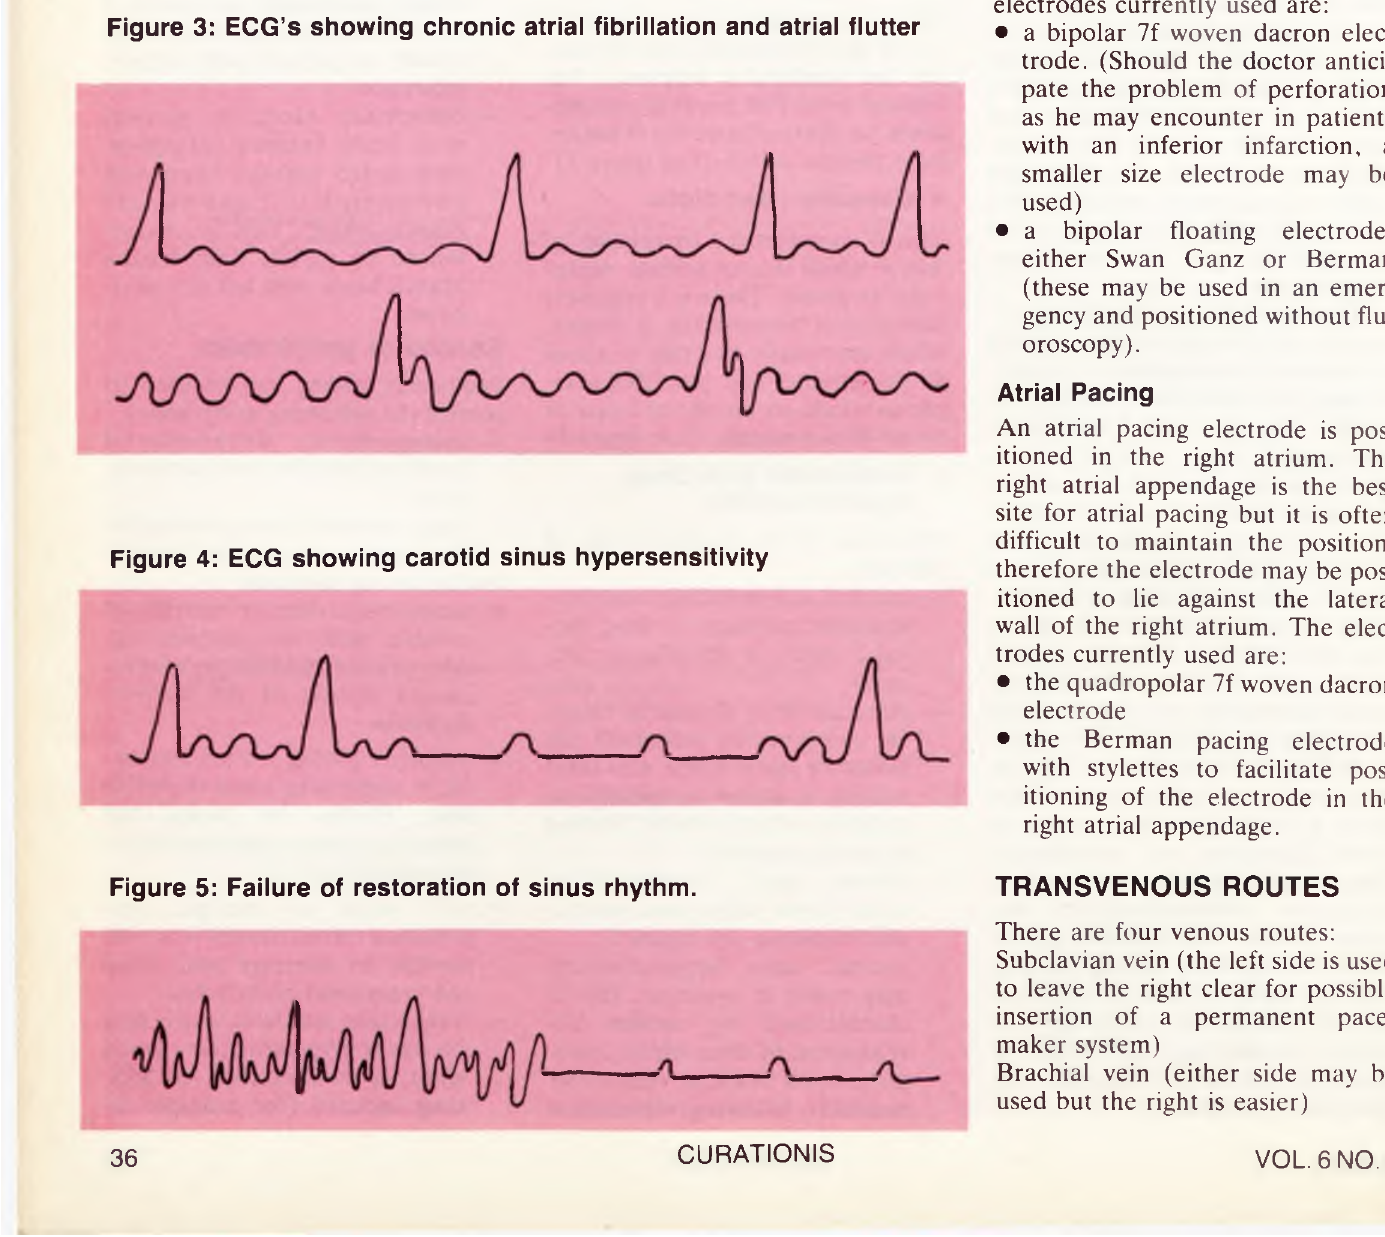
Figure 3: ECG’s showing chronic atrial fibrillation and atrial flutter